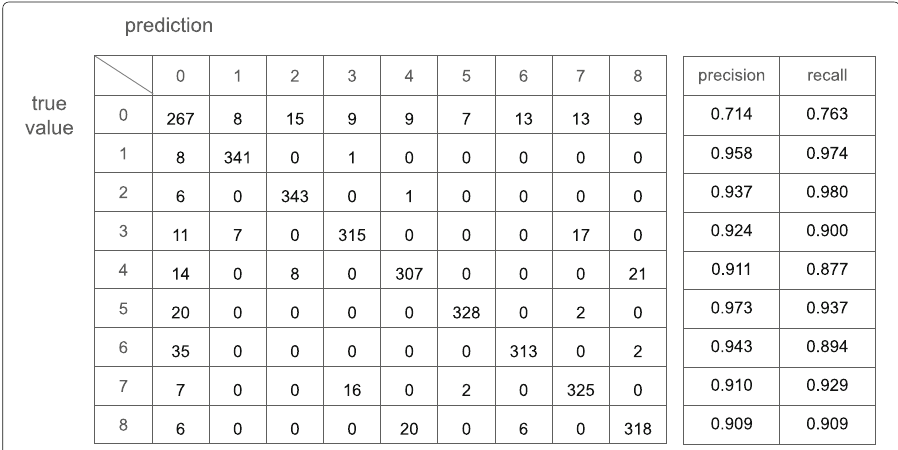
Fig. 19 The confusion matrix is from the real data framework. The accuracy is 90.7% on average